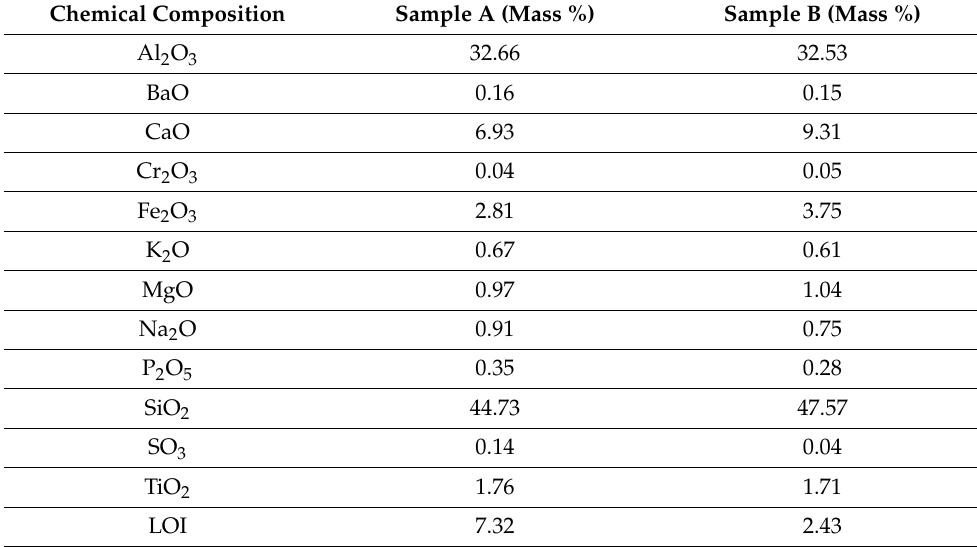
Table 3. XRF chemical composition analysis.